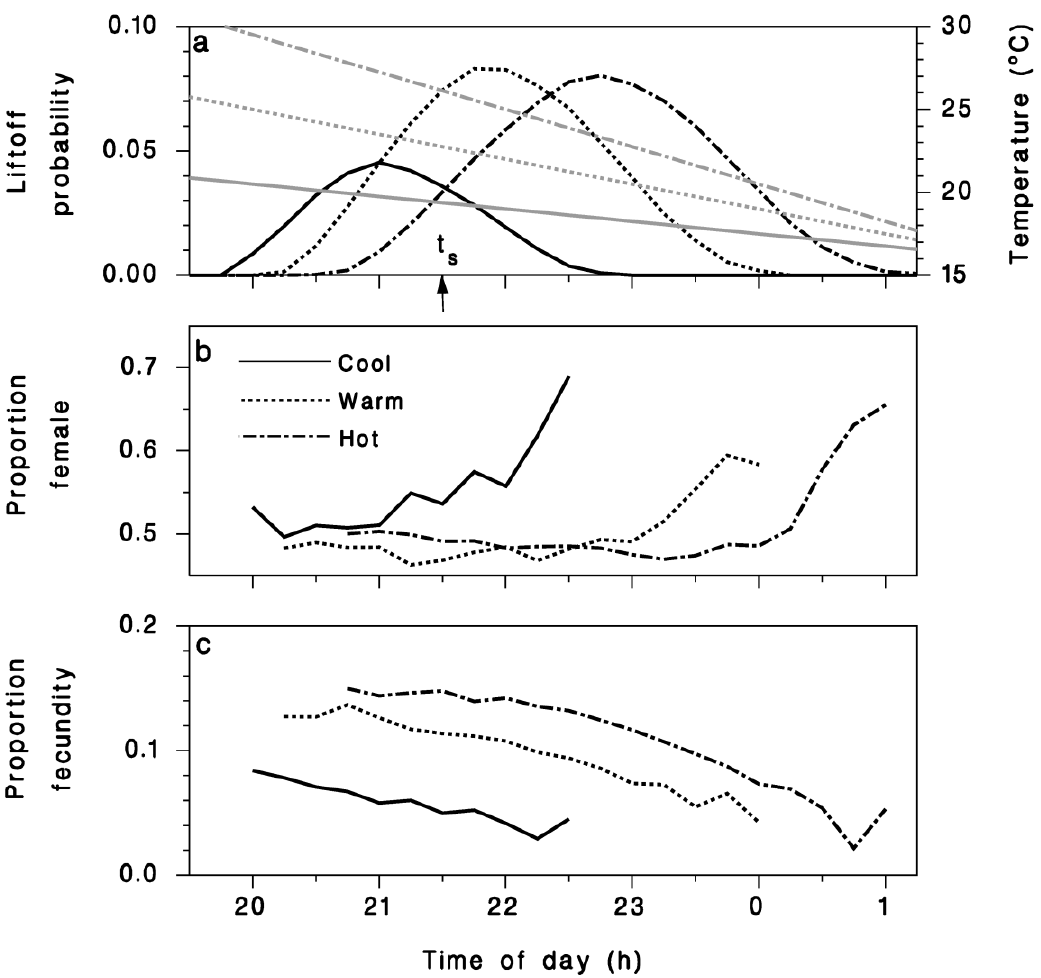
Figure 4. ( a ) Proportion of moths (black curves) emigrating under three temperature regimes (gray lines) on cool (solid), warm (dotted), and hot (dash-dotted) nights. ( b ) Proportion female among the moths emigrating at each time step. ( c ) Average proportion of initial fecundity carried away by emigrating females (Equation (10)).